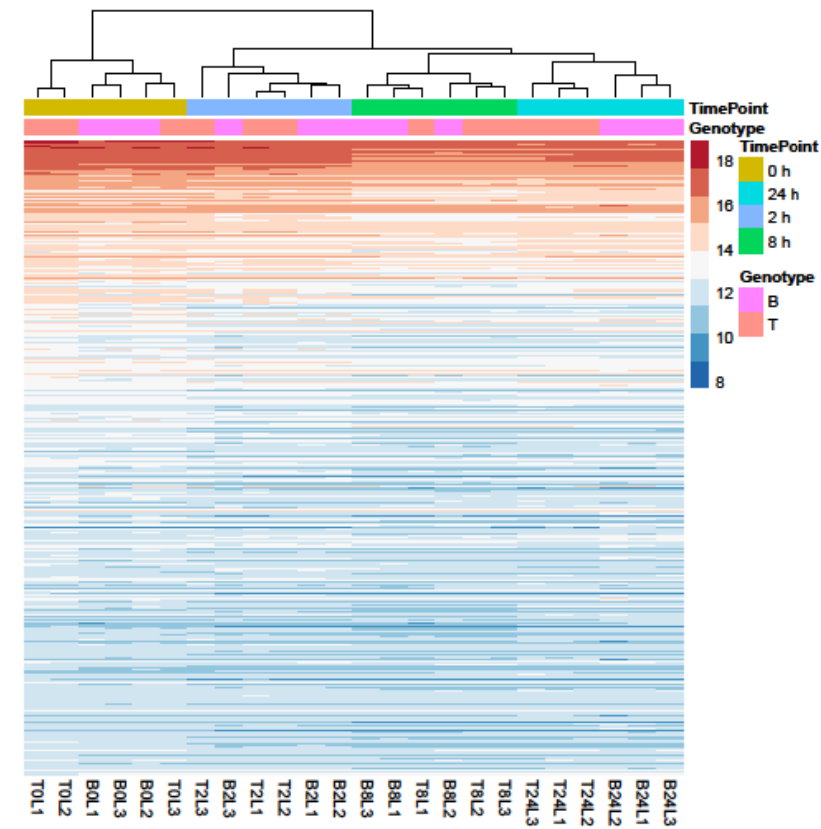
Figure 2. Profiles of the 500 genes with the greatest variance in expression. Data were collected over four durations (0, 2, 8, and 24 h) of salt treatment in Boulifa (B, pink) and Testour (T, orange) seedlings. The colors indicate expression level of genes (see key on right). Sampling time points and genotypes (L1, L2, and L3) are shown above cluster plot. Biological replicates are labeled on the x -axis. The dendrogram (top) indicates sample clustering.